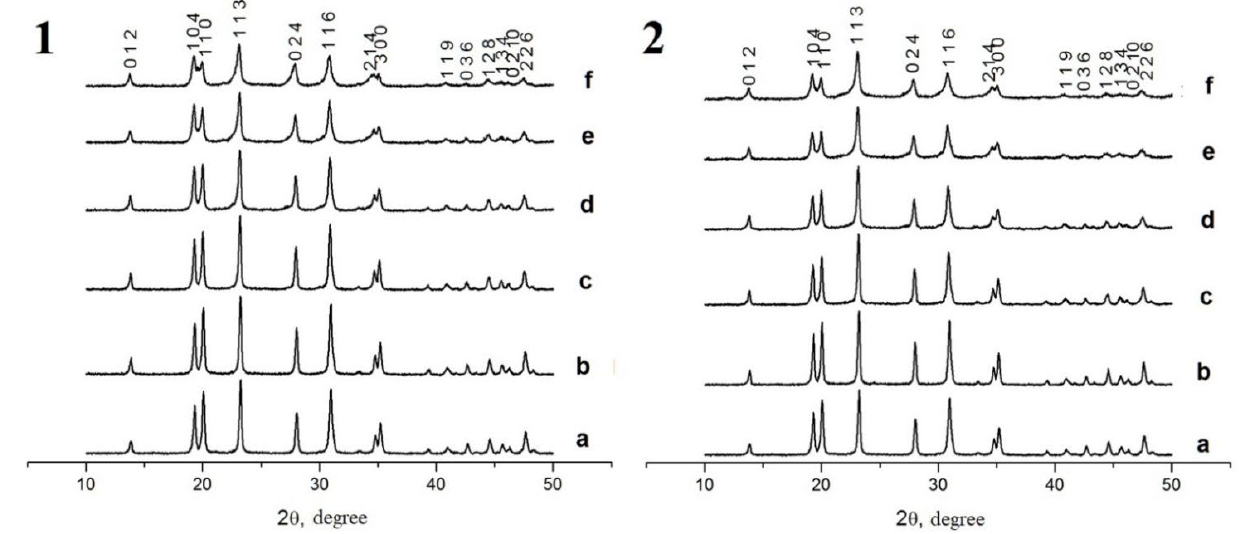
Figure 6. XRD data. Phosphate Na 1-x Zr 2 (PO 4 ) 3-x (XO 4 ) x compounds, X = Mo ( 1 ), W ( 2 ), x = 0 (a), 0.1 (b), 0.2 (c), 0.3 (d), 0.4 (e), 0.5 (f).